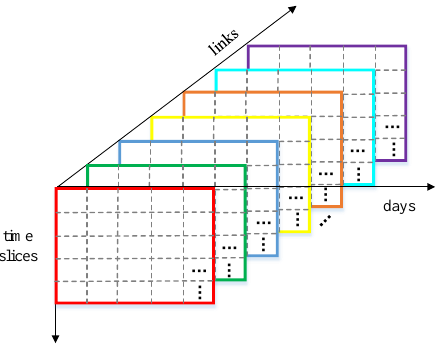
Figure 2. Traffic flow data tensor.